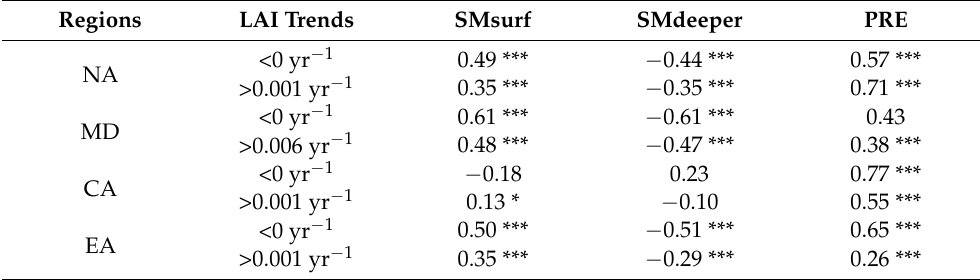
Table 3. Partial correlation coefficient between LAI and precipitation, surface soil moisture, and deeper soil moisture (*, p < 0.05; ***, p < 0.001). Regions LAI Trends SMsurf SMdeeper PRE <0 yr − 1 0.49 NA